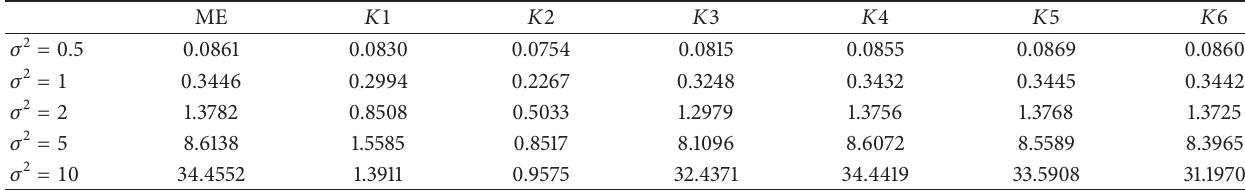
Table 19: Estimated MSE with 𝑛 = 50 , 𝑝 = 8 , and 𝛾 = 0.95 .